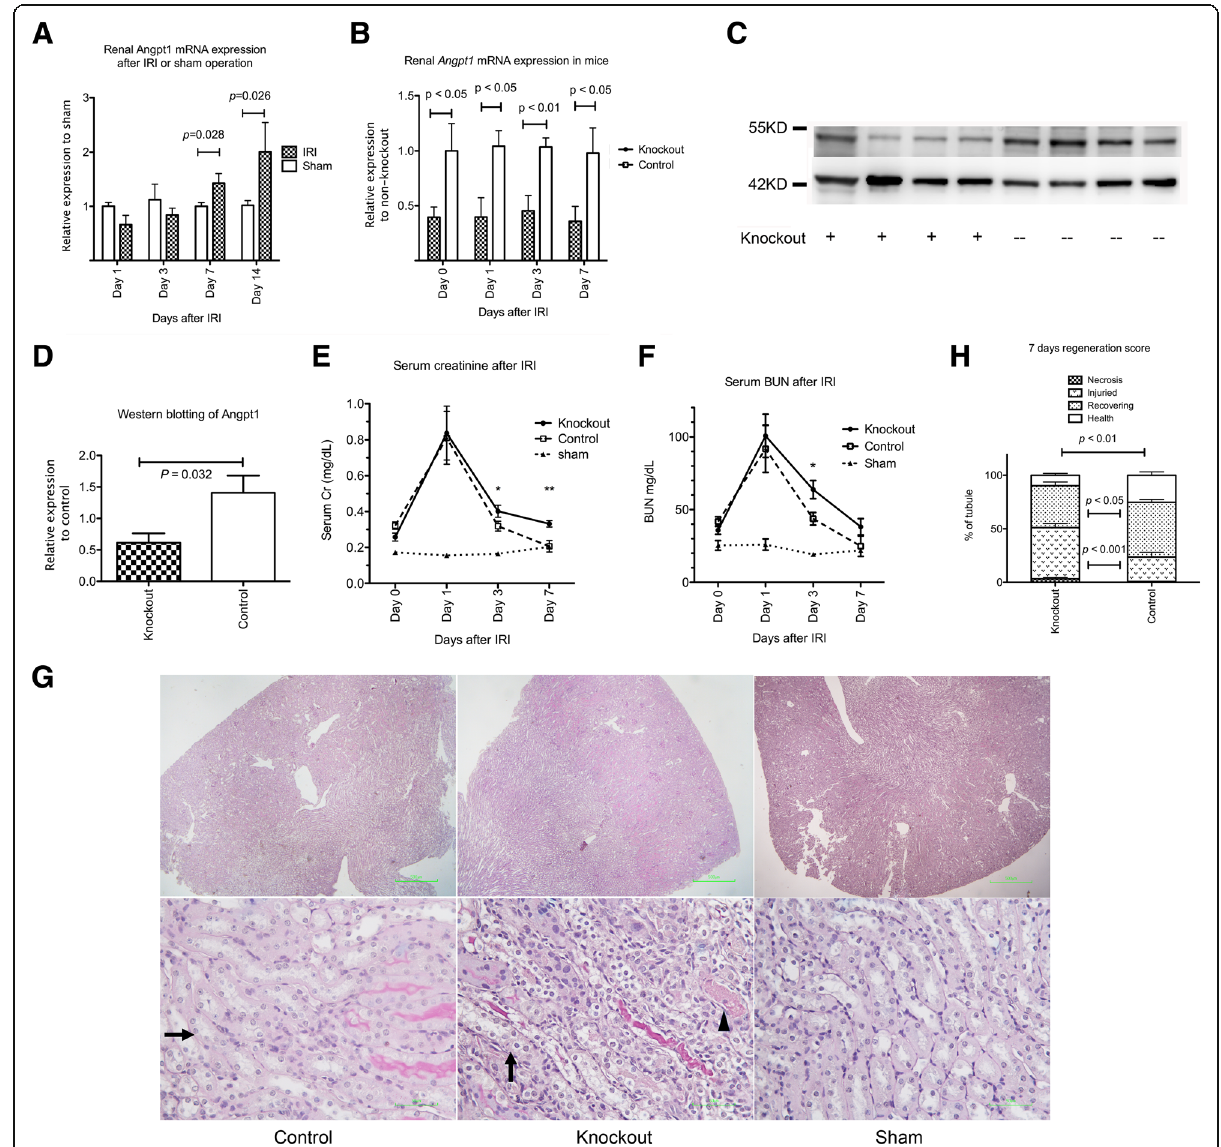
Fig. 2 a Expression of Angpt1 mRNA 1, 3, 7, and 14days after IRI in wild mice. The expression of Angpt1 increased 7days and 14days after IRI. ( N =6 per sham and IRI groups at each time point) b The expression of Angpt1 in kidney was significantly suppressed in the Angpt1 knockout mice on the day of IRI and 1, 3, or 7days after IRI compared to that in the control mice ( N =6, 6, 12, and 17 in knockout group on day 0, 1, 3, and 7days respectively, N =6, 6, 12, and 15 in control group on day 0, 1, 3, and 7days respectively, P <0.05 or P <0.01) c & d Western blotting of mouse Angpt1 3days after IRI. The Angpt1 protein level was lower in the knockout than control mice. ( N =5 for each group, P <0.05) e Serum creatinine level was higher in the Angpt1 knockout mice 3 and 7days after IRI. ( N =17 in knockout group, N =15 in control group, N =5 in the sham group, * P <0.05, ** P <0.01) f Serum BUN level was higher in Angpt1 knockout mice 3days after IRI. ( N =17 in knockout group, N =15 in control group, N =5 in the sham group, * P <0.05) g PAS staining of renal tissue in control, knockout and sham mice. The remaining tubular necrosis was more severe and the renal tubular recovery was less in the knockout mice 7days after IRI. Arrow indicates recovery tubule. Arrow head indicates necrotic tubule. h Semi-quantitative analysis of the regeneration score in the control and knockout mice. The recovery percentage was lower and the necrosis percentage was higher in the Angpt1 knockout mice 7days after IRI ( N =17 in the knockout group, N =15 in the control